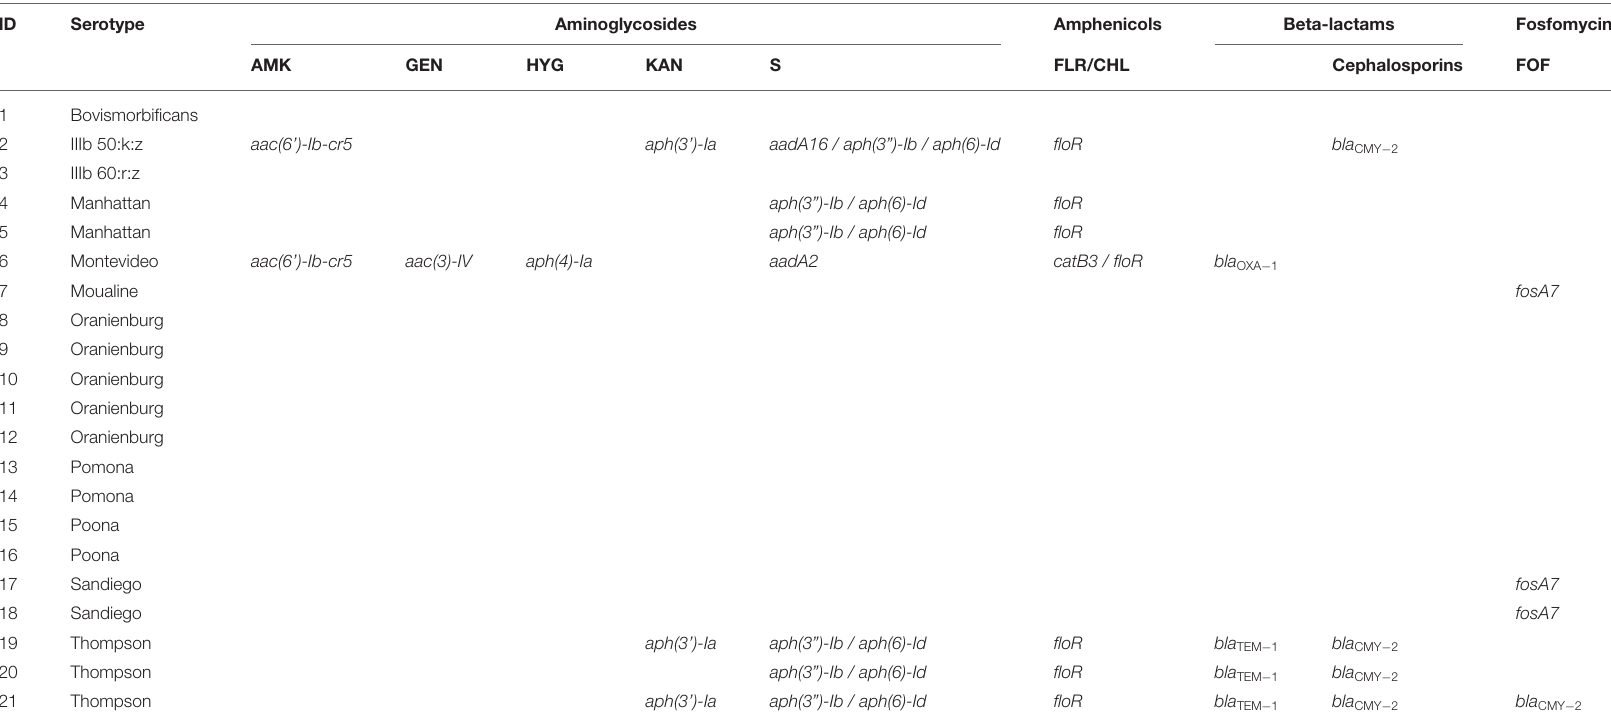
TABLE 4a | Antimicrobial resistance genes identified in Salmonella enterica isolates from